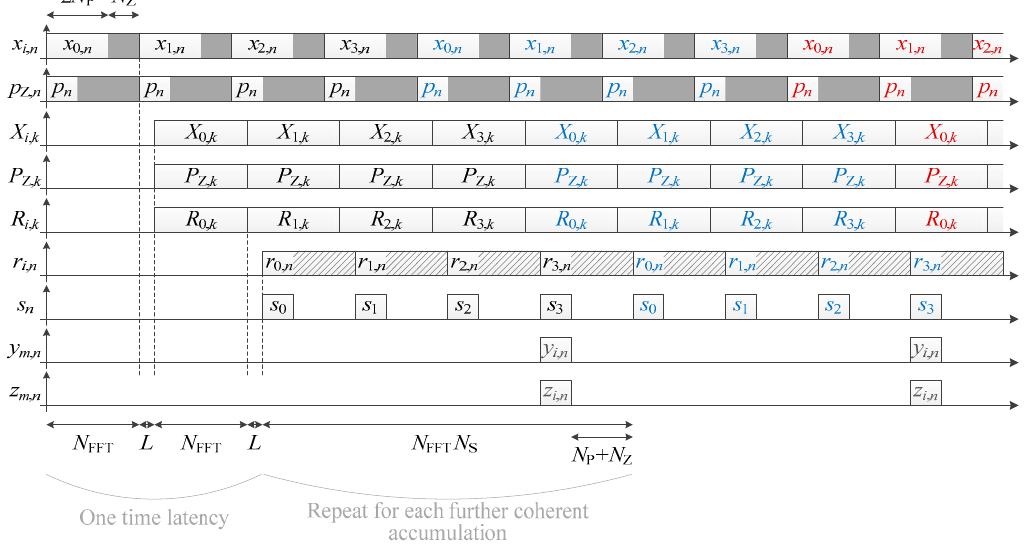
Figure 5. Timing diagram of the pilot channel acquisition shown in Figure 4, with N S = 4 for the illustration.